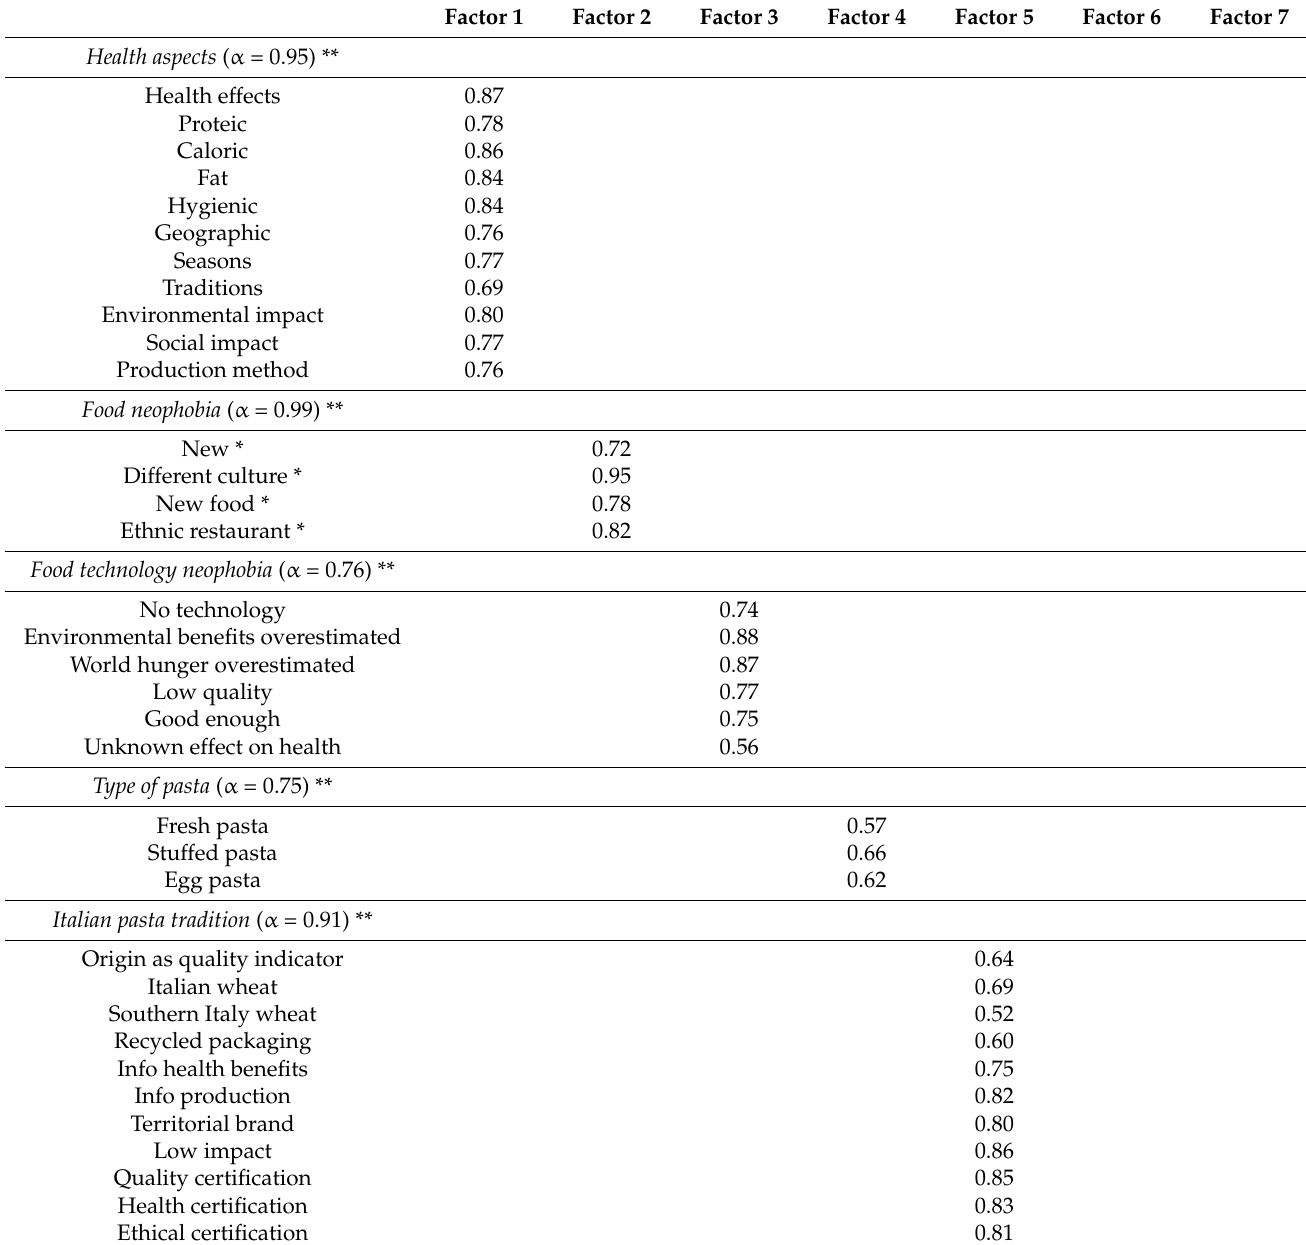
Table 5. Factor analysis with a varimax